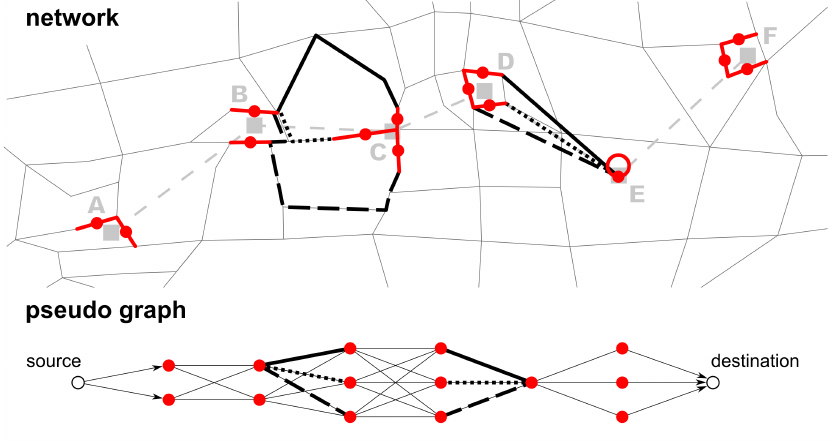
Figure 4. The least-cost path in the network between two link candidates ( top ) is represented as one edge on the pseudo graph ( bottom ): the pseudo edge’s weight is the travel cost of the network path. Six paths and their corresponding edges on the pseudo graph are highlighted as